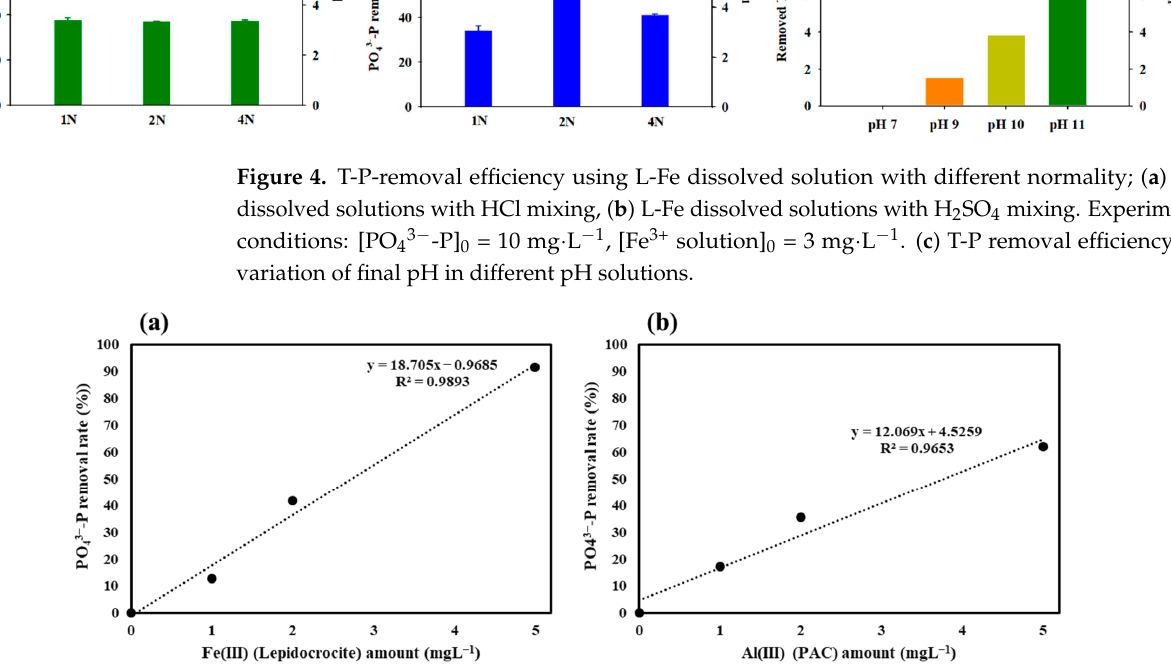
Figure 5. Removal efficiency of T-P by ( a ) L-Fe dissolved solutions prepared in 2 N H 2 SO 4 ( b ) and PAC.